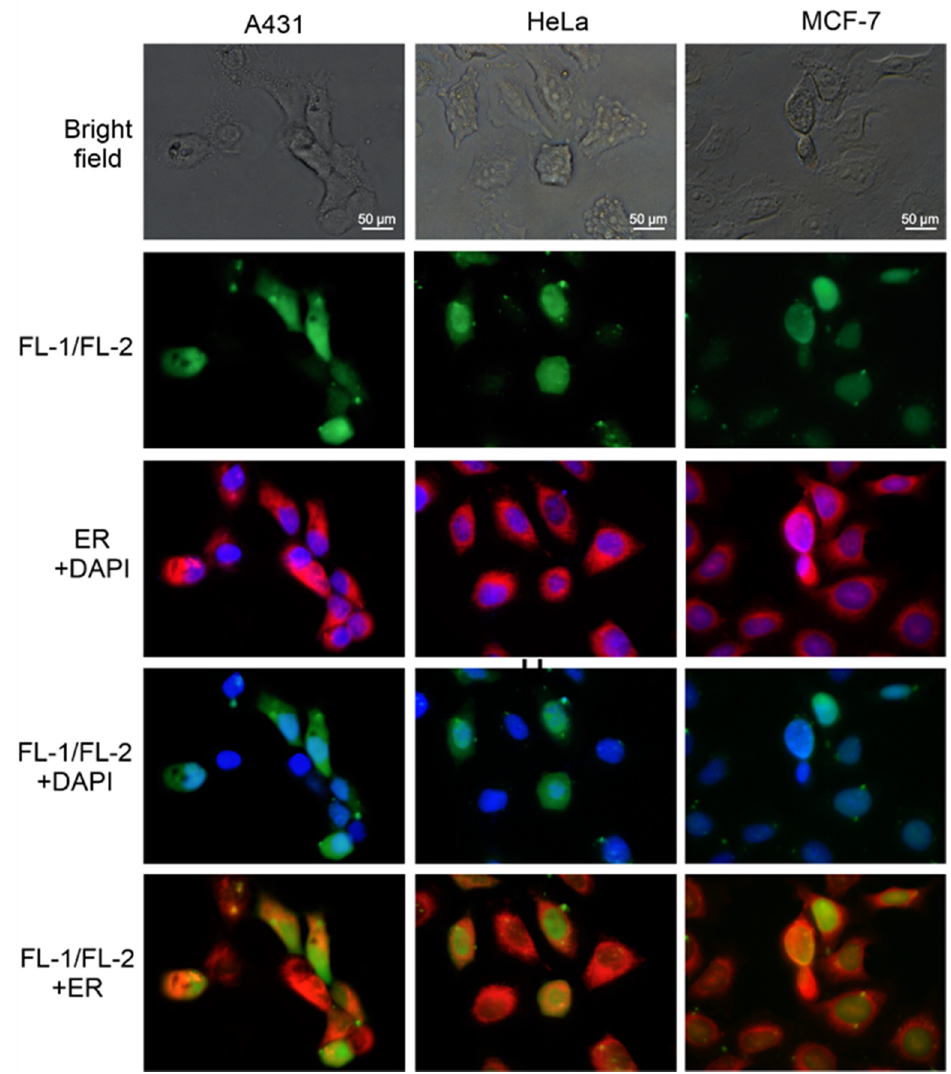
Figure 4. Localization of the FL-1/FL-2 nanostructures in A431, HeLa, and MCF-7 cancer cells (6 h after transfection). Visualization of green fluorescent B-ASO spots and merged blue cell nuclei (DAPI) and red ER membranes (ER-Tracker Red) are shown in rows 2 and 3, respectively. Merged images of the FL-1/FL-2 nanostructures either with cell nuclei or with ER are shown in rows 4 and 5, respectively. All panels were enlarged 60 times.